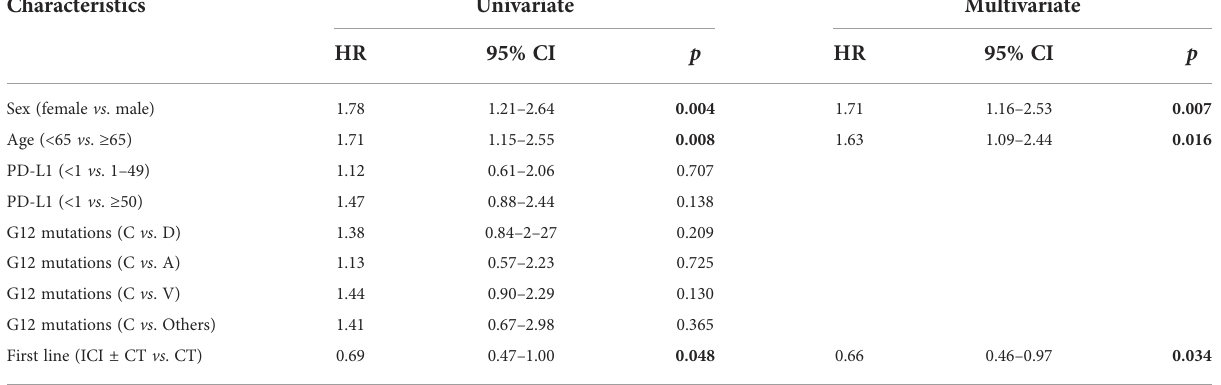
TABLE 3 Univariate and multivariate overall survival analysis.